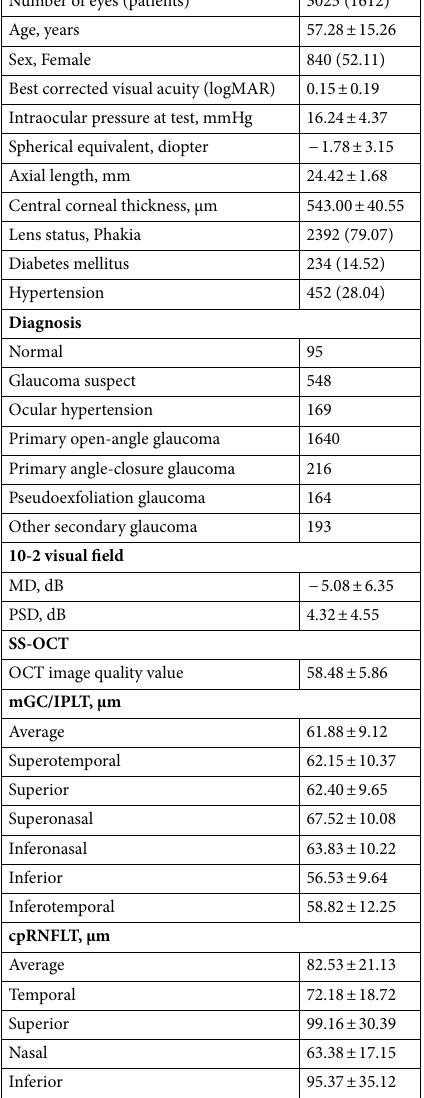
minimum angle of resolution; MD mean deviation; PSD pattern standard deviation; SS-OCT swept- source optical coherence tomography; mGC/IPLT macular ganglion cell/inner plexiform layer thickness; cpRNFLT circumpapillary retinal nerve fiber layer